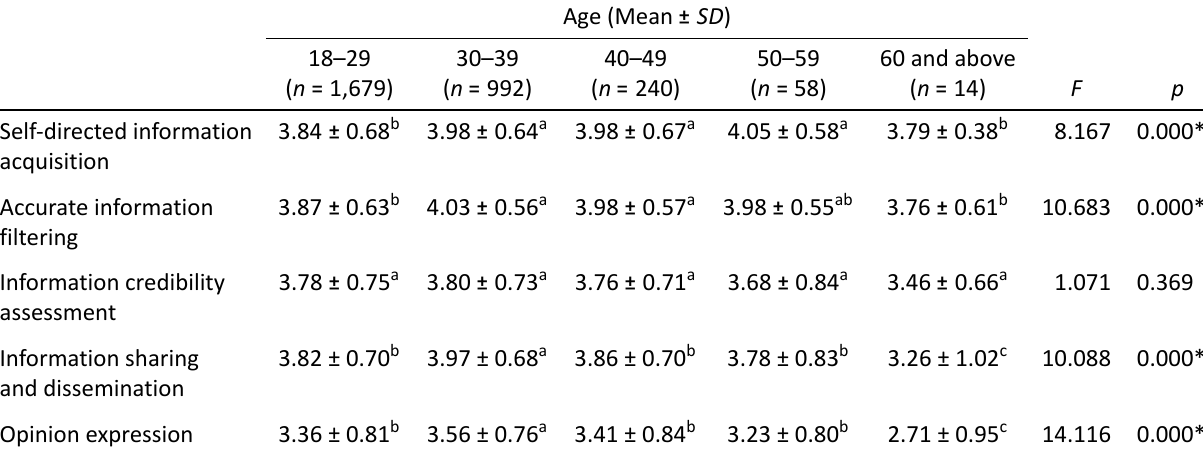
Table 8. Differences in information literacy levels by age group.